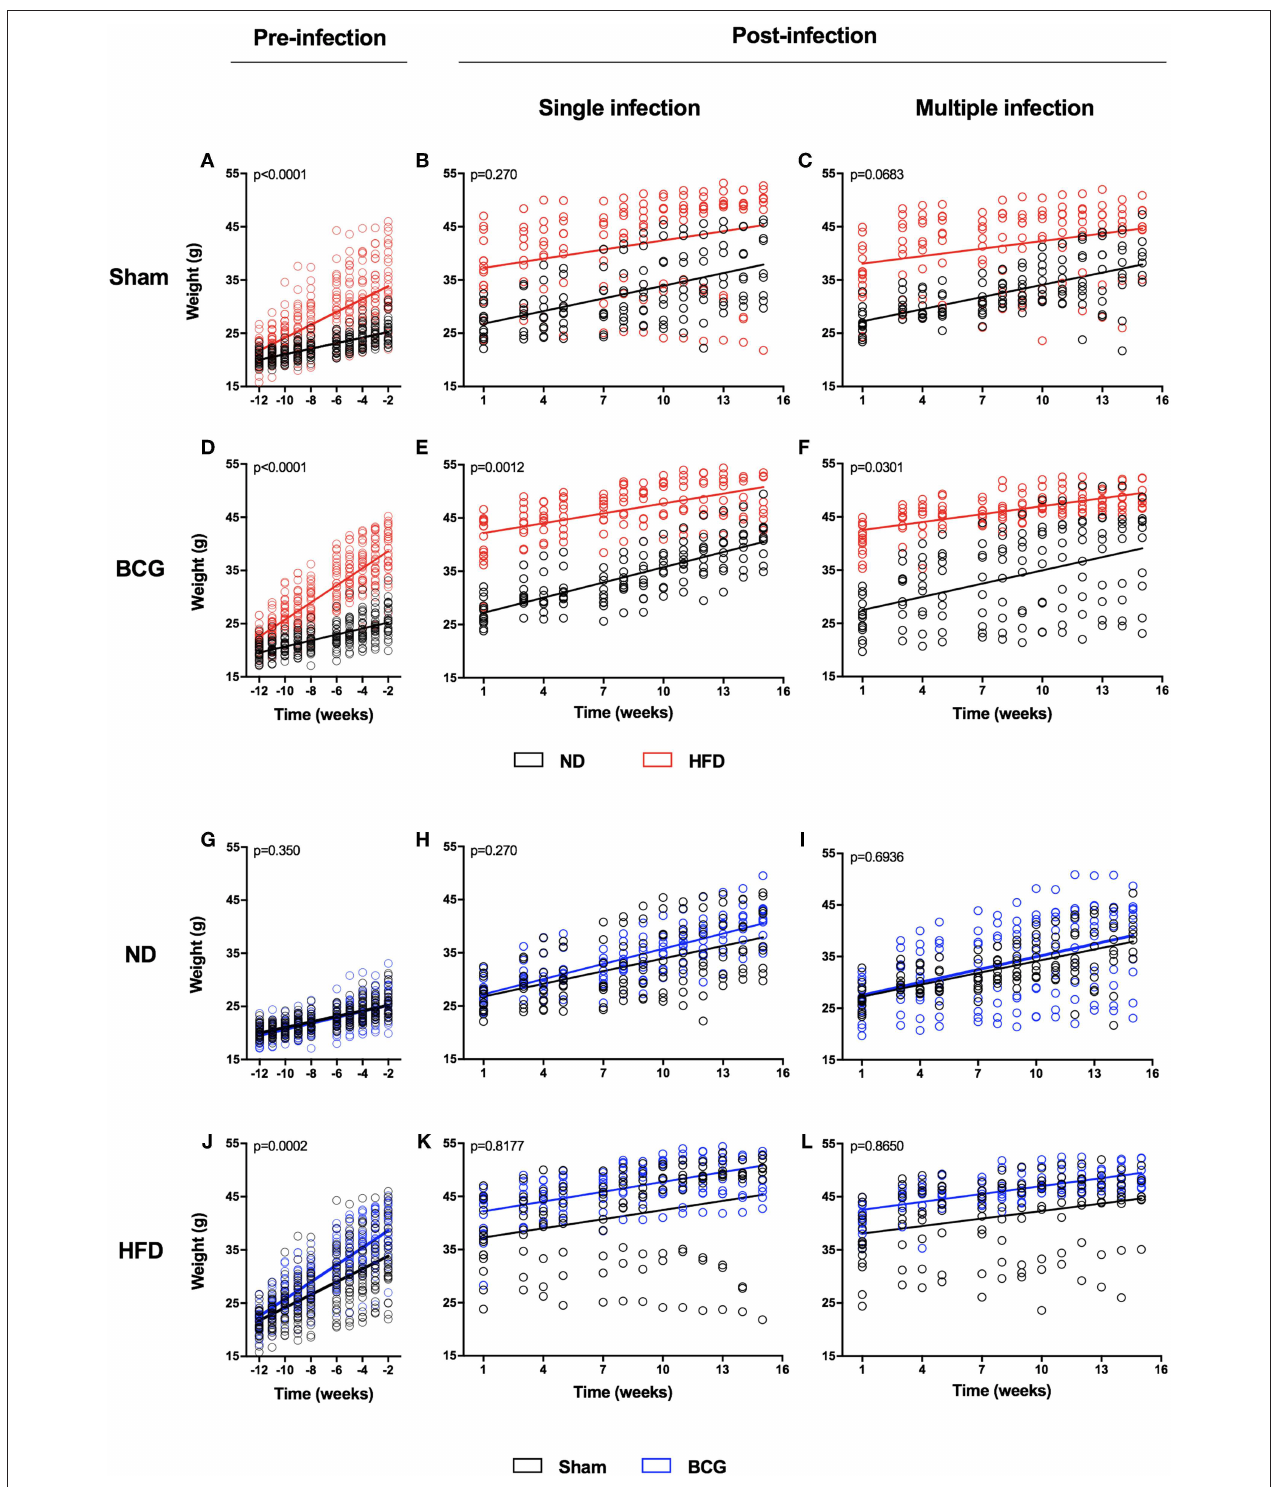
FIGURE 1 | Weight evolution during the experiment in pre- and post-infection status. Weight evolution of the same experiment is represented by comparing ND and HFD (A–F) and Sham and BCG (G–L) . Panels represent: pre-infection and sham (A) , SI and sham (B) , MCI and sham (C) , pre-infection and BCG (D) , SI and BCG (E) , MCI and BCG (F) , pre-infection and ND (G) , SI and ND (H) , MCI and ND (I) , pre-infection and HFD (J) , SI and HFD (K) , MCI and HFD (L) . Linear regression are represented together with p -values. Slopes’ values are included in Table S1 .